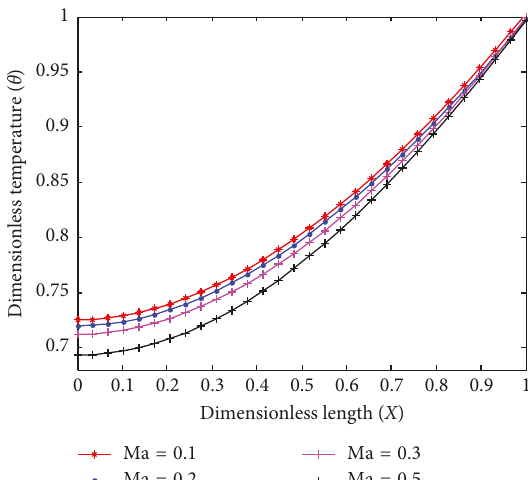
Figure 6: Effects of the magnetic field parameter on the temperature